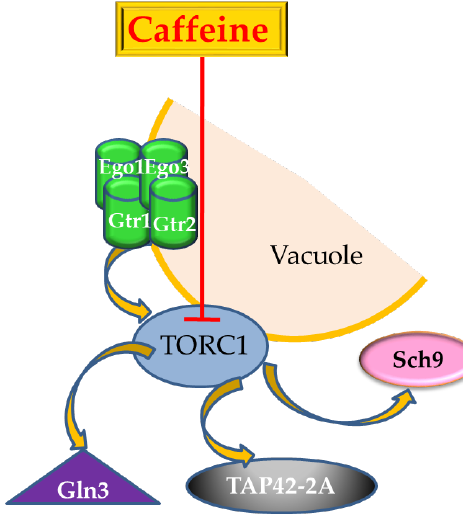
Figure 4. Upstream and downstream components of TORC1 regulation. EGO complex (localized on the vacuolar membrane), which consist in four proteins, Ego1 (a palmitoylated/myristolated protein); Ego3 (a transmembrane protein); and two Ras-family GTPases, Gtr1 and Gtr2, is a major regulator of TORC1 activity, via Tco89. The best characterized substrate of TORC1 is Sch9, a member of AGC family of kinases. When cells are stressed by caffeine, TORC1 is inhibited directly, and the Sch9 phosphorylation is reduced dramatically. TORC1 also regulates the 2A (Pph21, Pph22, and Pph3—generically PP2Ac) and 2A-related phosphatases, including the Tap42-PP2A effector. Inactivation of TORC1 by caffeine results in Tap42 dephosphorylation and TORC1 directly phosphorylate other substrates including Gln3. Adapted from [13,80,81,106].